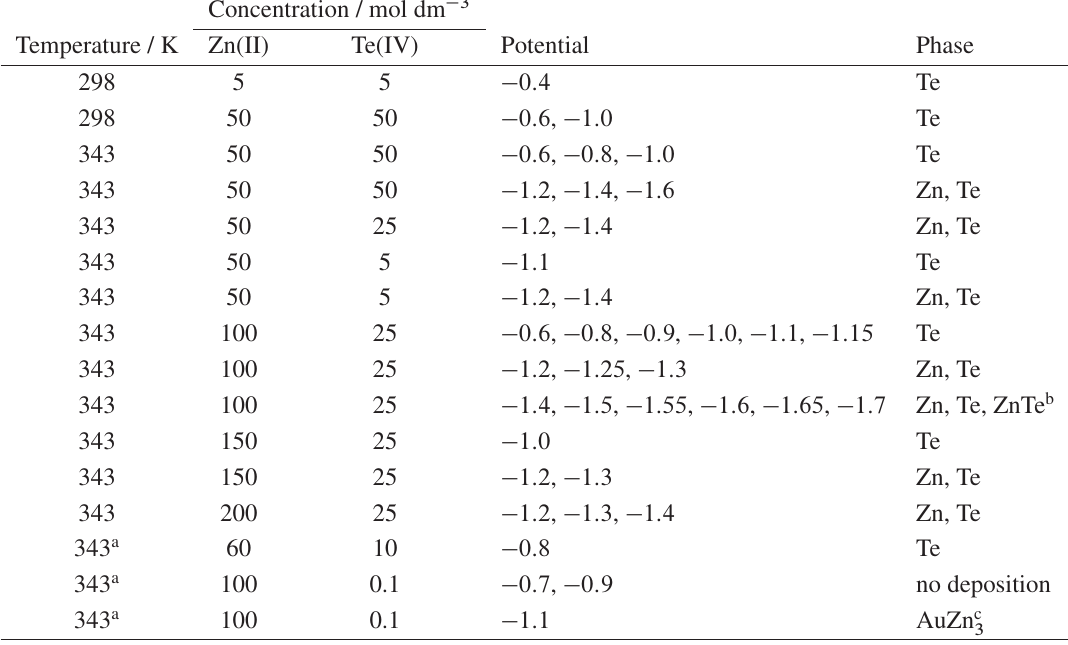
Table 2. Conditions for potentiostatic electrodeposition on Ti cathode from ammoniacal baths containing 4.0 mol dm (cid:3) 3 NH 3 and 0.5 mol dm (cid:3) 3 (NH 4 / 2 SO 4 (pH 10.7), and resulting phases identified by X-ray